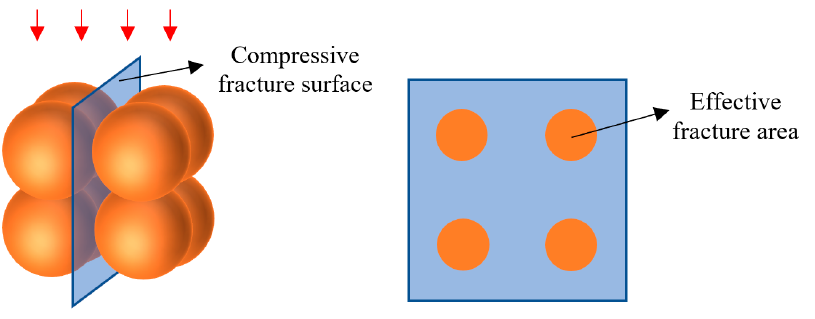
Figure 17. Fracture surface of compression damage.